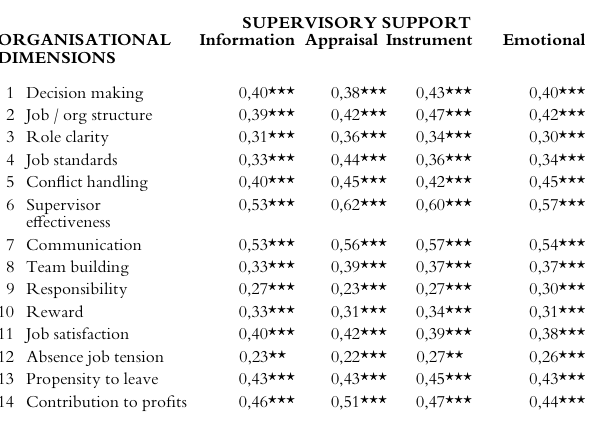
TABLE1 CORRELATIONSBETWEENCLIMATE DIMENSIONS